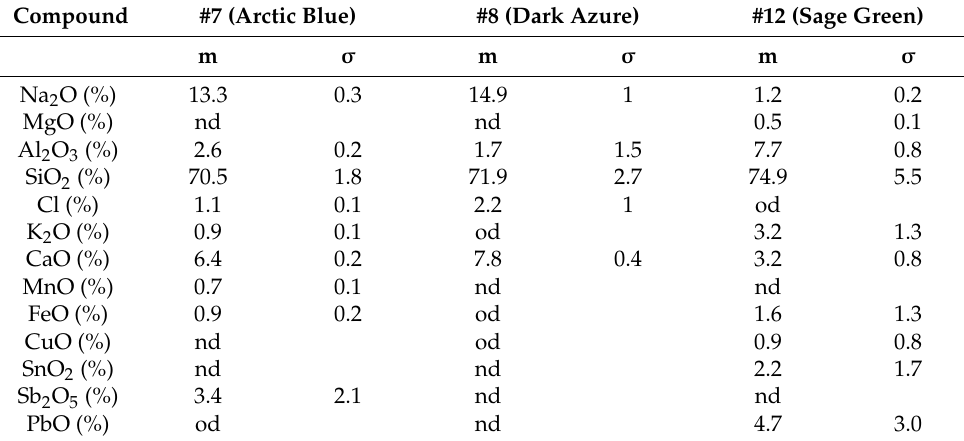
Table 2. Arithmetic means (m) and standard deviations ( σ ) of the chemical composition (wt%) obtained by SEM-EDS on several small areas (free of visible microcrystals) of the three sampled glass tesserae.